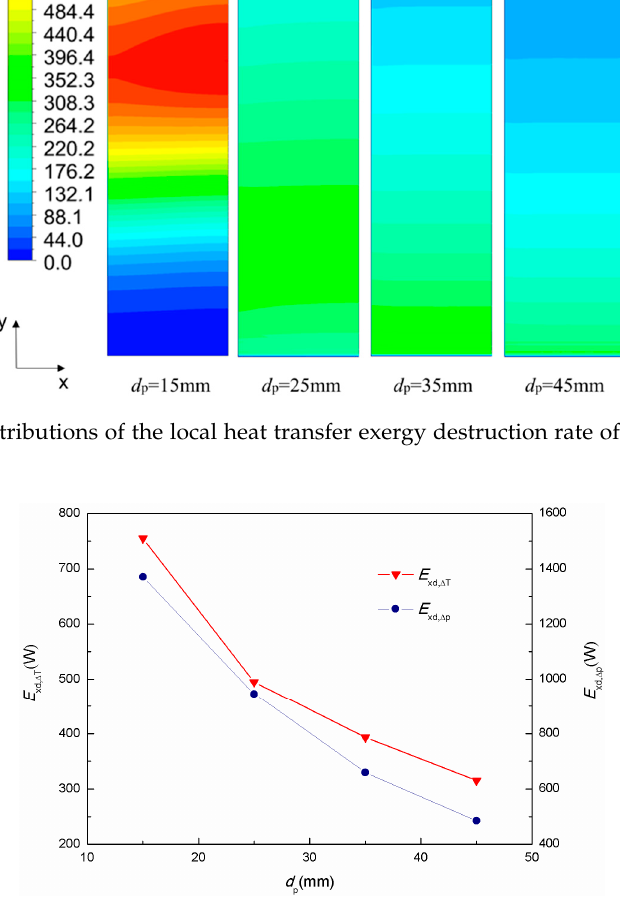
Figure 19. Influence of the sinter particle diameter on exergy destruction caused by heat transfer and fluid flow.